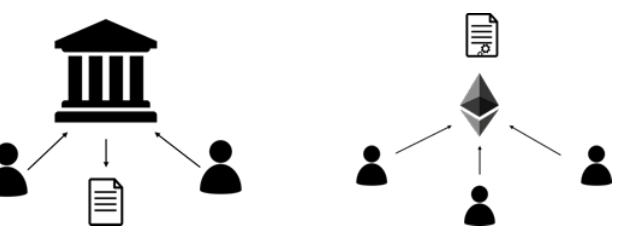
Figure 2. Traditional contractual agreement system vs Smart Contract